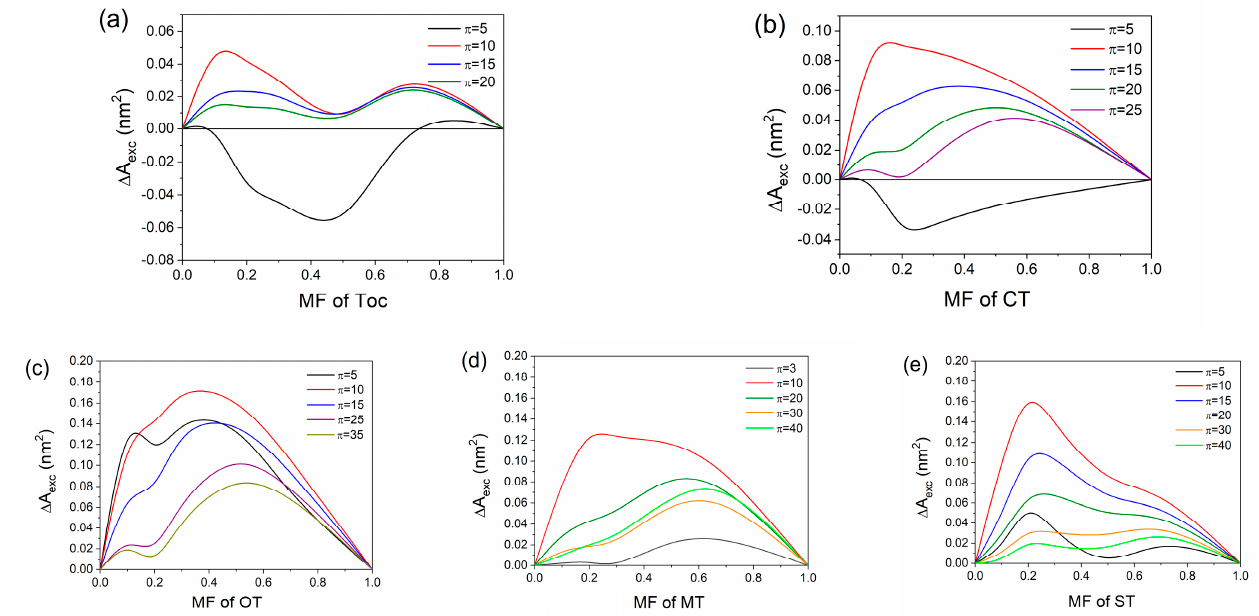
Figure 4. Excess area ( ∆ A exc ) versus mole fraction (MF) of ( a ) Toc, ( b ) CT, ( c ) OT, ( d ) MT, and ( e ) ST, obtained at different surface pressure (mN/m), as shown in legend.